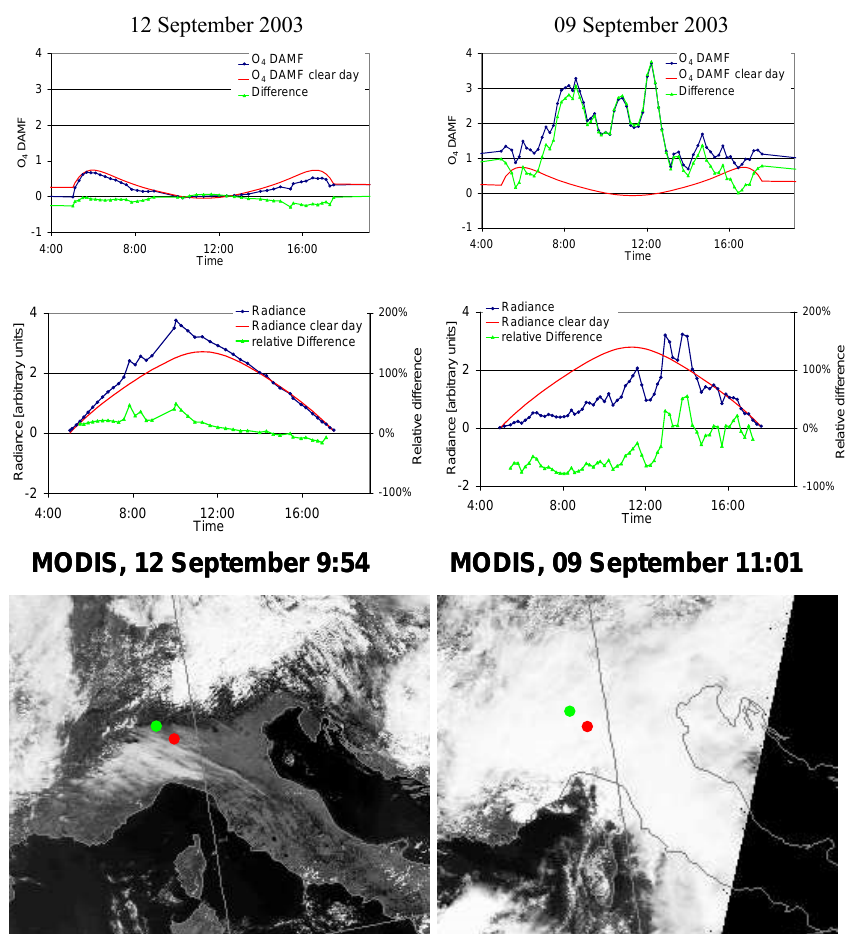
Fig. 13 Comparison of the O4 DAMFs (top) and the radiance (middle) of selected days (blue curves) with those of clear sky reference days (parameterised by polynomials of 5 th order, red curves). The difference of the O4 DAMFs with respect to the clear sky reference (normalised O 4 DAMF, see Eq. 19) is shown as green curve. Also the relative difference of the radiance with respect to the clear sky reference (normalised radiance, see Eq. 18) is shown as blue curve. On the selected days the MAX-DOAS measurements were affected by sporadic thin clouds (left) or thick cloud cover (right) as also indicated by the MODIS satellite images in the bottom panel. As clear sky reference observations of 6 and 14 September 2003 were used.